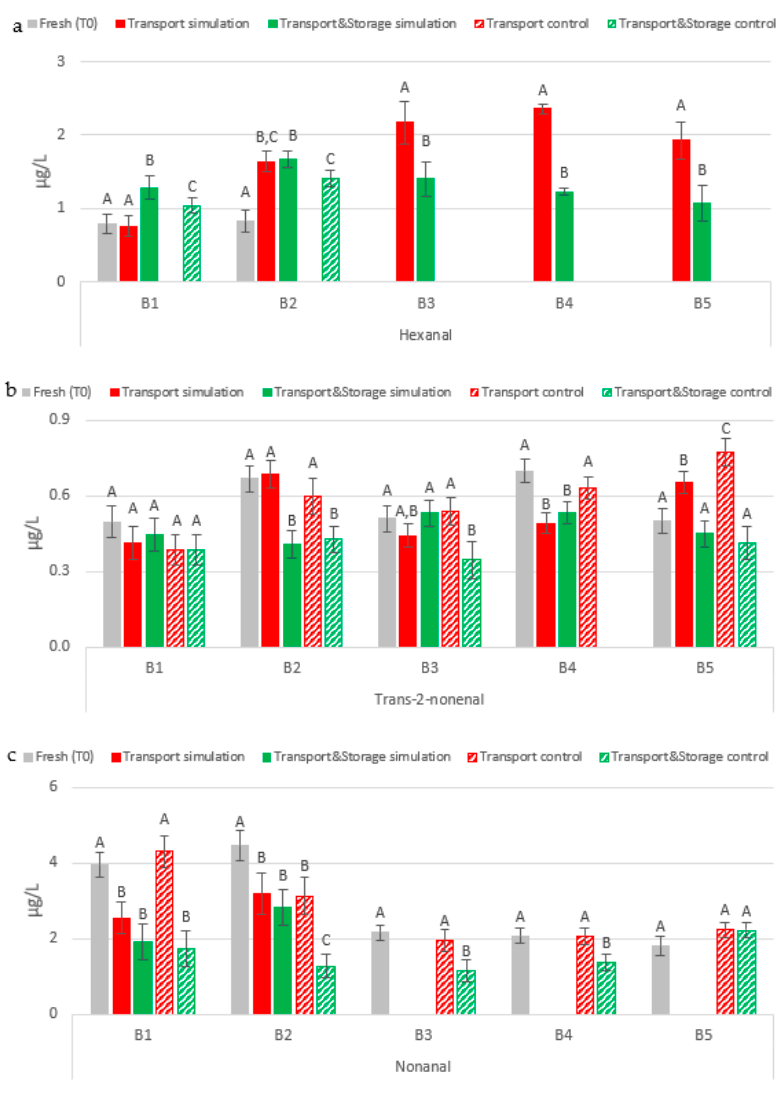
Figure 3. Evolution of lipid oxidation aldehydes under simulated conditions: ( a ) Hexanal; ( b ) Trans -2-nonenal; ( c ) Nonanal. A Tukey test was performed for each batch. Different letters represent statistically significant differences ( p < 0.05).